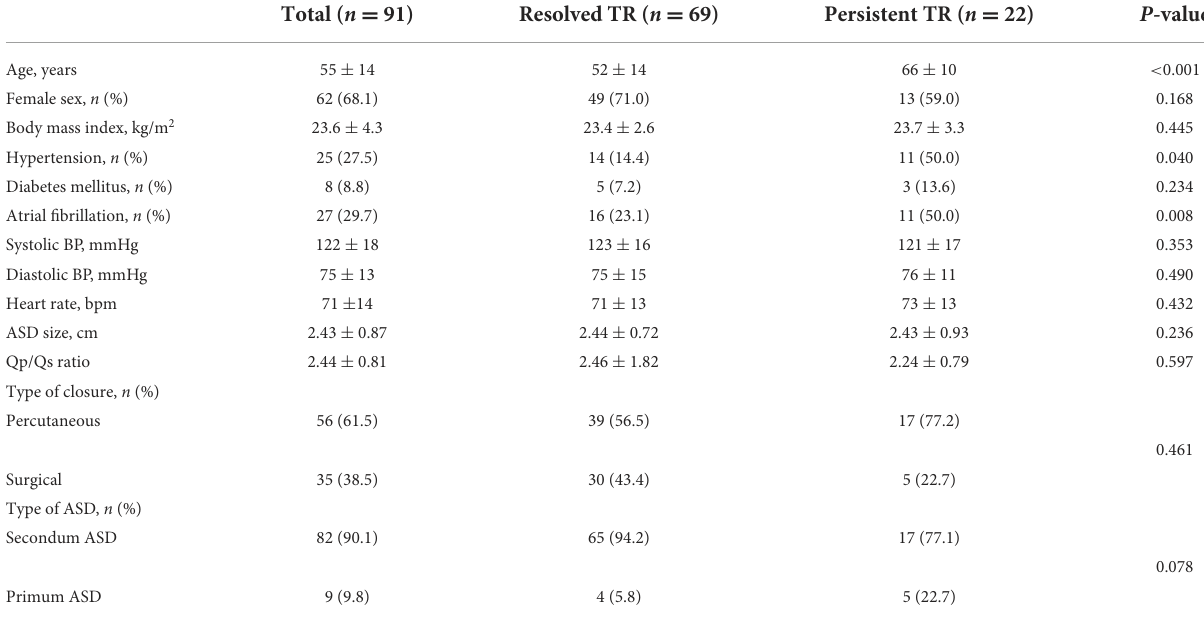
TABLE 1 Baseline characteristics of the study